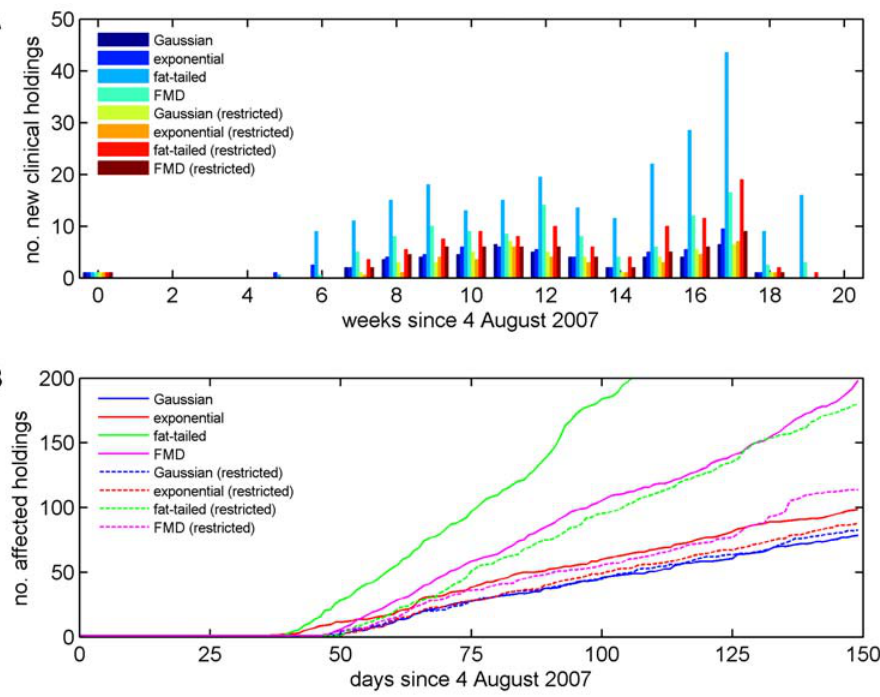
Figure 5. Sensitivity of temporal dynamics of BTV-8 to different transmission kernels. Comparison of (A) the median number of newly- identified holdings with confirmed clinical cases and (B) the cumulative number of affected holdings over time for different transmission kernels, where transmission between farms is either unrestricted or restricted to the 2007 protection zone. The figures are based on the results of 50 simulated outbreaks which took off (see